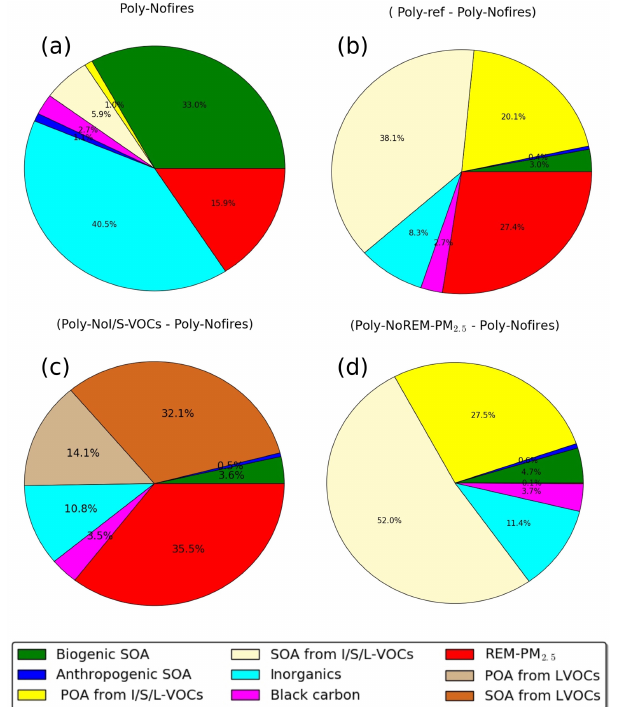
Figure 6. Composition of surface PM 2 . 5 concentration over MedReg2 during the second fire event ( a simulation Poly-Nofires). Composition of surface PM 2 . 5 concentration due to fires ( b simu- lation Poly-ref; c simulation Poly-noI/S-VOCs; d simulation Poly- NoREM-PM 2 . 5